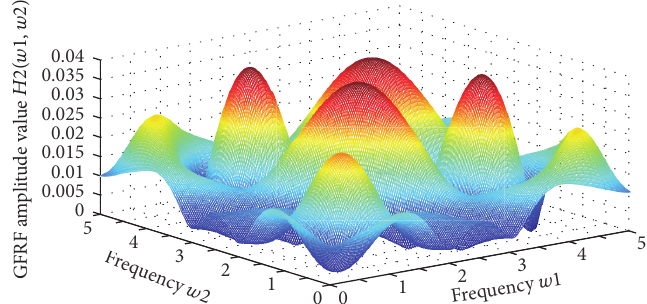
Figure 5: The frequency domain kernels of the shaft system in overspeed test.